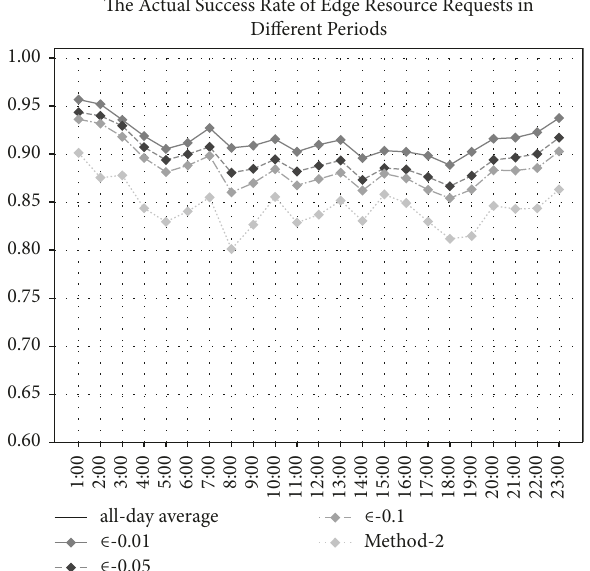
Figure 10: The success rate of edge resource requests on different